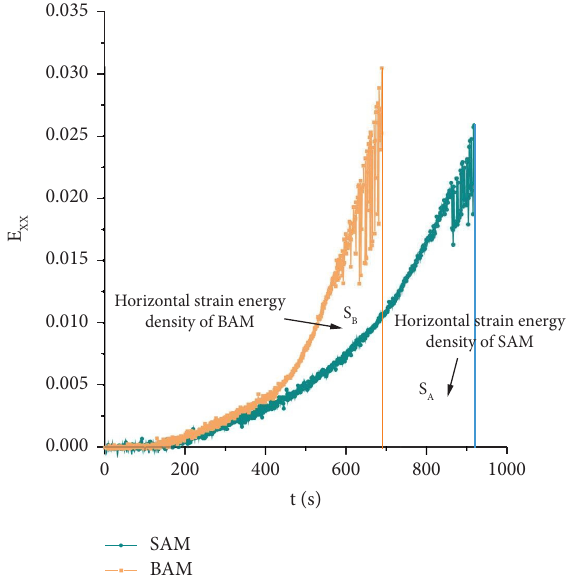
Figure 9: Horizontal strain energy density of SAM and